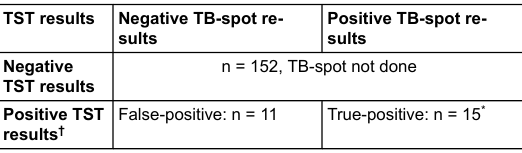
Table 2: Tuberculin skin test results and TB-spot results in children aged ≥5 years *